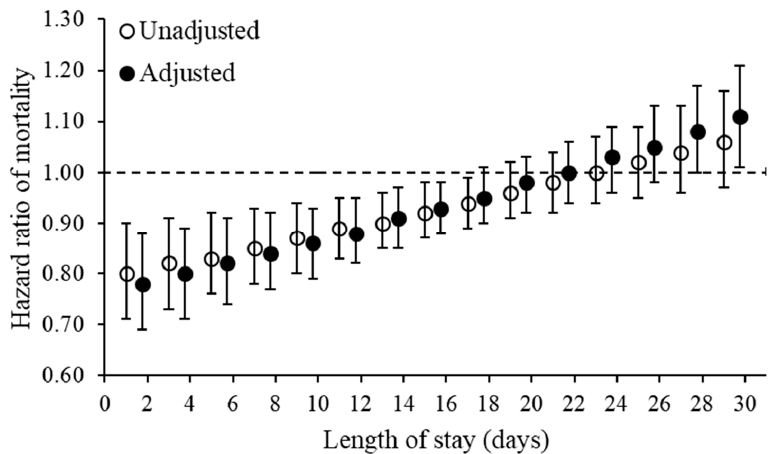
Figure 2. Therapy volume by length of stay effect on mortality. Examining the interaction between the acute care/rehabilitation average physical/occupational therapy cost/day and length of stay for the out- come, 1-year mortality rate, among adults with cerebral palsy with an incident fragility fracture. The open and closed circles represent the hazard ratio (vertical lines are the 95% confidence interval) of mortality ( y -axis) for the average physical/occupational therapy cost/day for that length of stay at 1, 3, 5, and every other day until 29 days ( x -axis). The same length of stay was estimated for the unadjusted and adjusted models, but positioned next to one another on the graph as opposed to on top of one another to enhance visual interpretation. If the 95% confidence interval (vertical lines extending from the open/closed circles) cross 1.00 (dashed line), the association is not statistically significant at p < 0.05. The adjusted model accounted for age and the Whitney Comorbidity